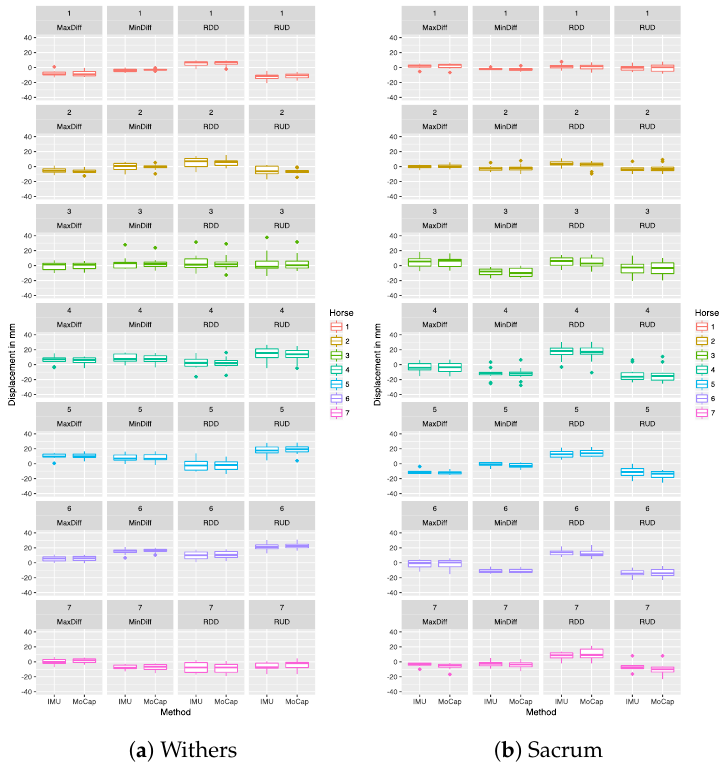
Figure A3. Box plot for the upper-body vertical displacement parameters of IMU and